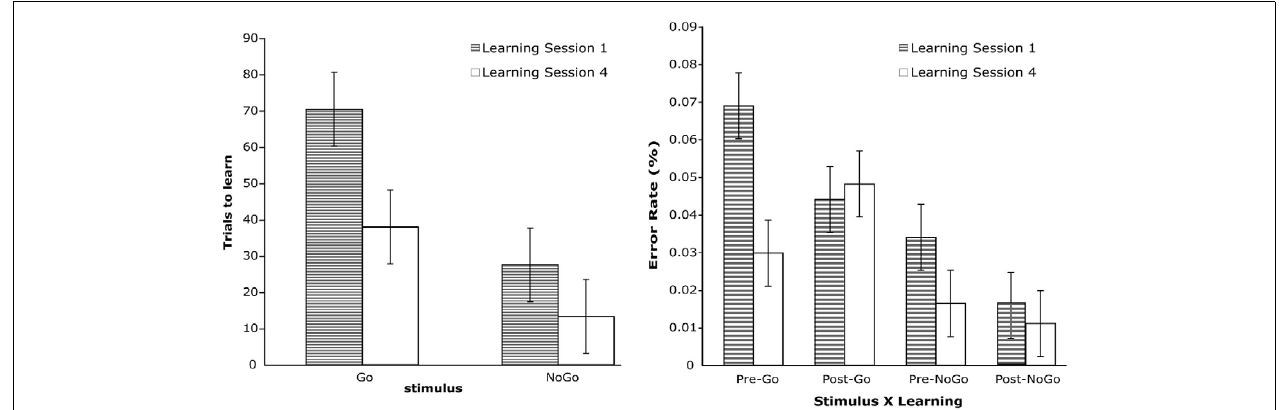
FIGURE 1 | Left: average of total trials to learn for stimulus type and learning session. Right: error rate for stimulus type, learning, and learning session.